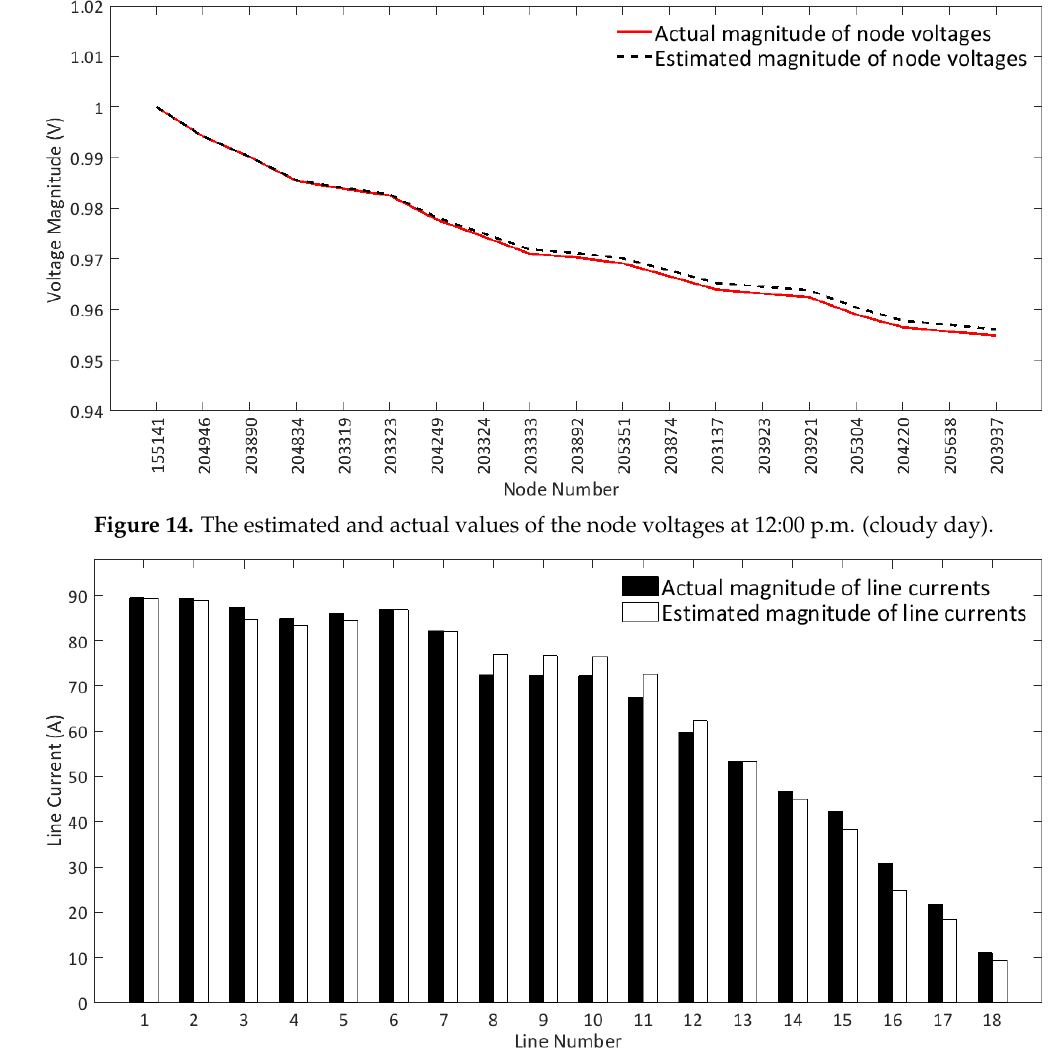
Figure 15. The estimated and actual values of the line currents at 12:00 p.m. (sunny